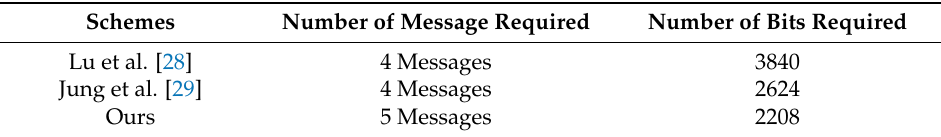
Table 4. Communication cost comparisons of our scheme and the two related